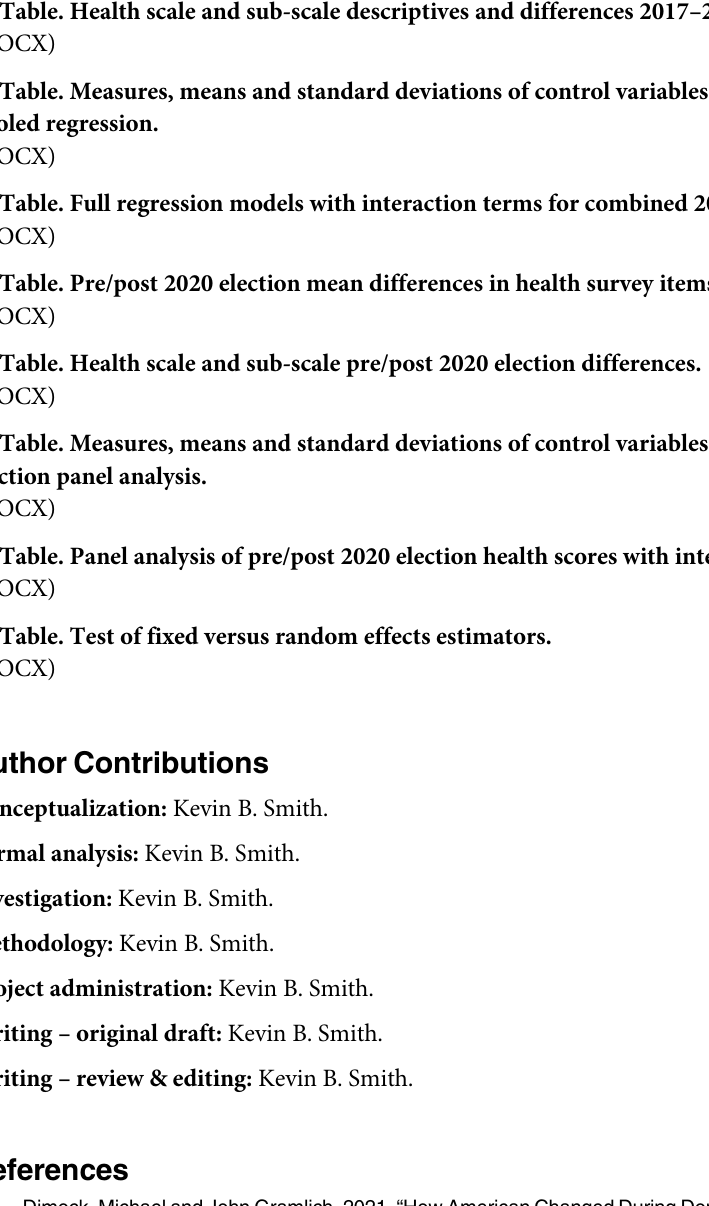
S1 Table. Descriptive statistics and mean differences in health survey items 2017 vs. 2020. S2 Table. Health scale and sub-scale descriptives and differences 2017–2020. S3 Table. Measures, means and standard deviations of control variables used in 2017–2020 pooled regression. S4 Table. Full regression models with interaction terms for combined 2017–2020 sample. S5 Table. Pre/post 2020 election mean differences in health survey items. S6 Table. Health scale and sub-scale pre/post 2020 election differences. S7 Table. Measures, means and standard deviations of control variables used in pre/post election panel analysis. S8 Table. Panel analysis of pre/post 2020 election health scores with interaction terms. S9 Table. Test of fixed versus random effects